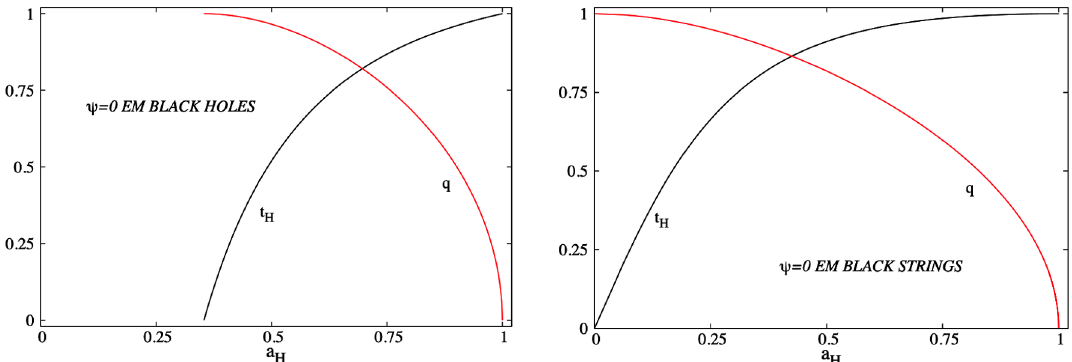
Figure 7 . The reduced charge and Hawking temperature are shown as a function of reduced event horizon area for the BH and the BS solutions in Einstein-Maxwell